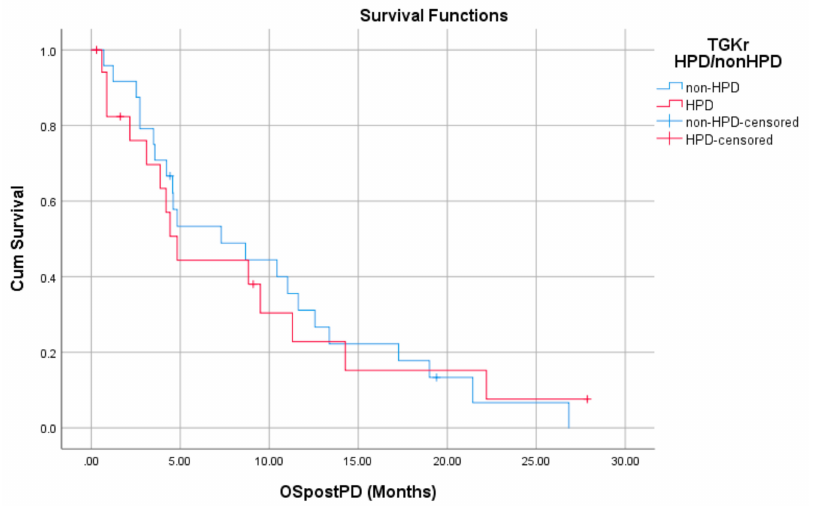
Figure 3. Association of type of progressive disease (PD) (HPD vs. non-HPD) with post-PD survival. There was no significant difference in post-PD survival between patients with HPD as compared to patients with non-HPD (median 4.83 months (95% CI, 3.61–6.04) vs. 7.30 months (95% CI, 1.09–13.51), p = 0.872).